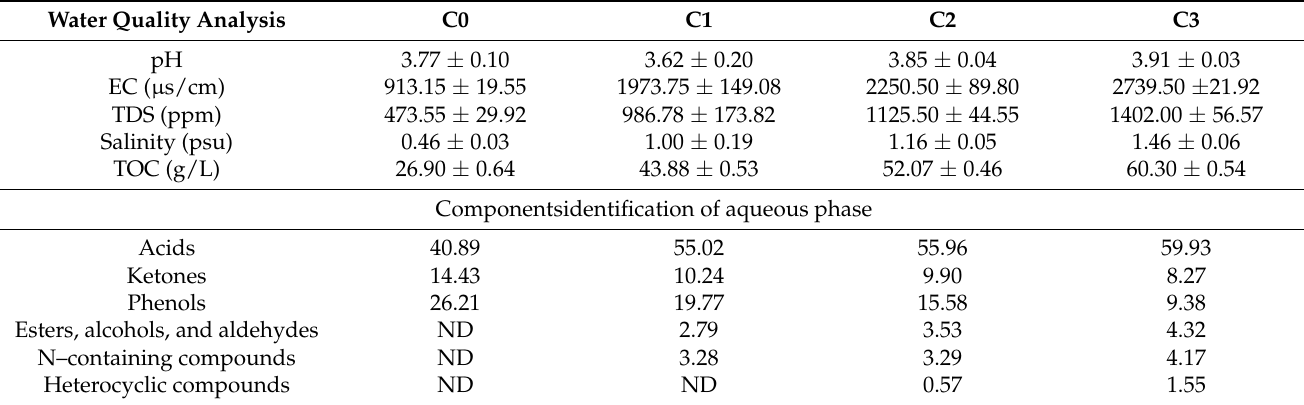
Table 2. The effect of aqueous phase accumulation recycling on its properties.